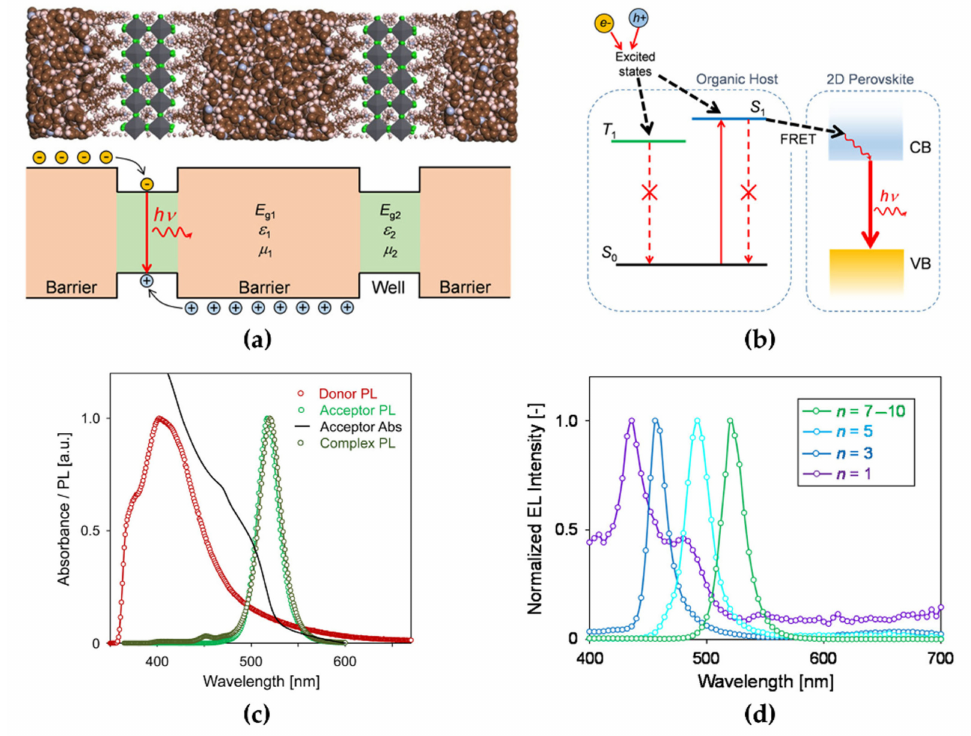
Figure 10. ( a ) Schematic (bottom) and molecular model (top) of the dielectric quantum wells formed between organic barriers and 2D perovskite wells. ( b ) Schematic of Förster resonance energy transfer (FRET) process occurring at the interface between the organic host and 2D perovskites (the singlet excitons in the host transferred to the conduction band [CB] of 2D perovskite). ( c ) Absorption and PL spectra of the donor (red circle), acceptor (green circle), and complex (dark green circle; the spectral overlap results in FRET from donor to acceptor). ( d ) EL spectra of 2D perovskite-based LEDs with nanoplatelet (NPL) solutions of n = 7 − 10 (pure green), n = 5 (sky blue), n = 3 (pure blue), and n = 1 (deep blue). Reprinted with permission from [77], Copyright 2016 American Chemical